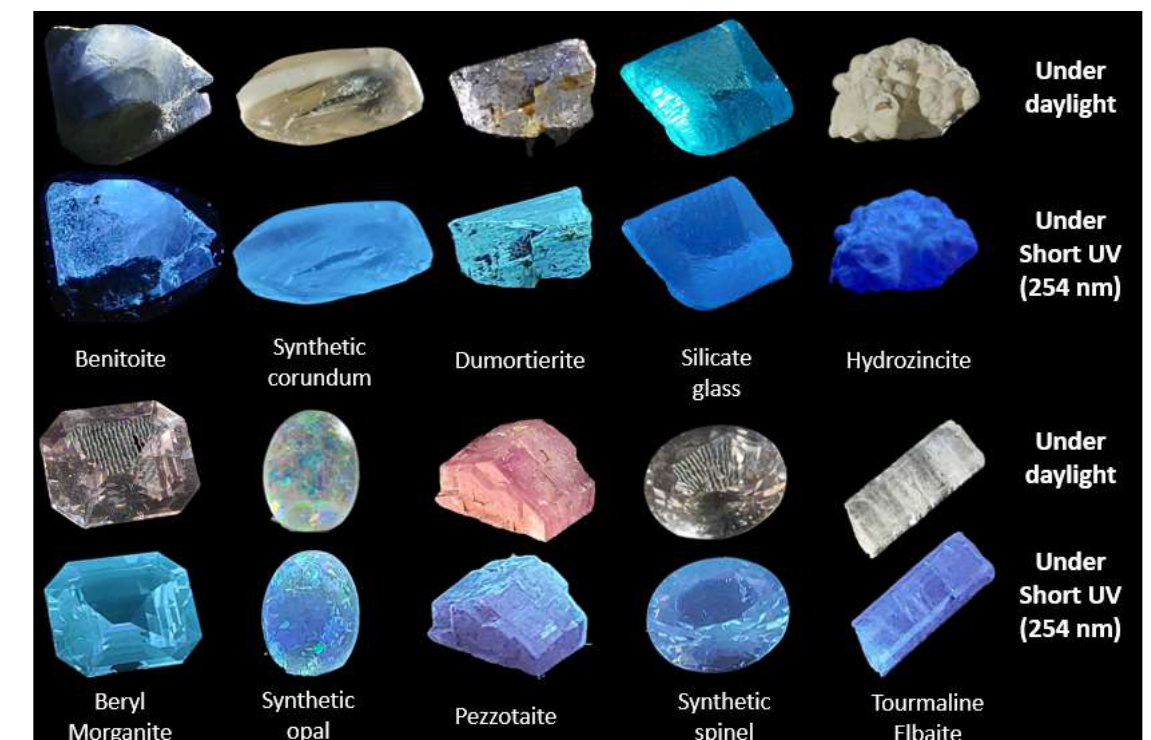
Figure 1. Photo under daylight and under shortwave UV (254 nm) of the ten representative samples of BSL phenomena. (Photo: Maxence Vigier).